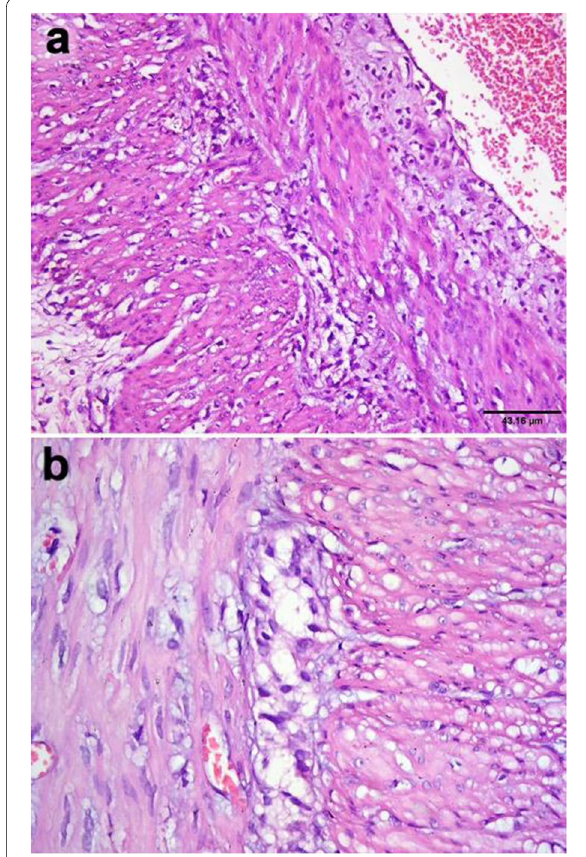
Fig. 3 A case of clinically queried Hirschsprung’s disease: small immature ganglion cells and hypertrophied myenteric nerve plexus (H&E, 200) ( a ). Higher magnification showing the myenteric plexus, × including immature ganglion cells with a high nuclear-cytoplasmic ratio and inconspicuous nucleoli (H&E, 400) ( b ×